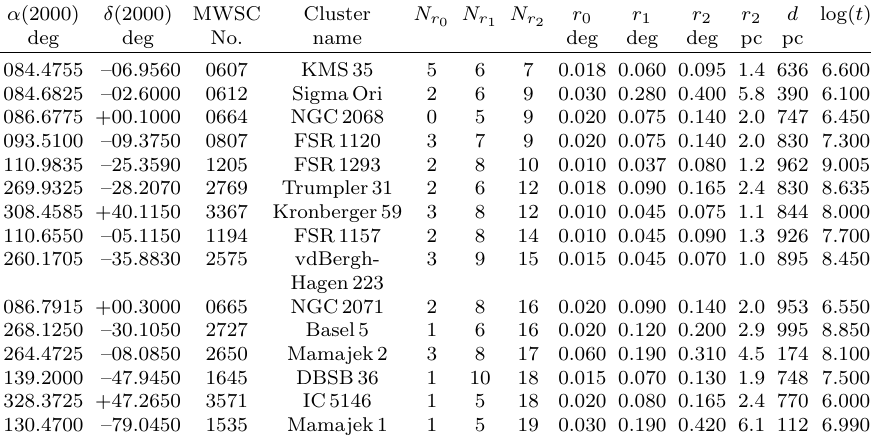
Table 2. Sparsely populated clusters from MWSC